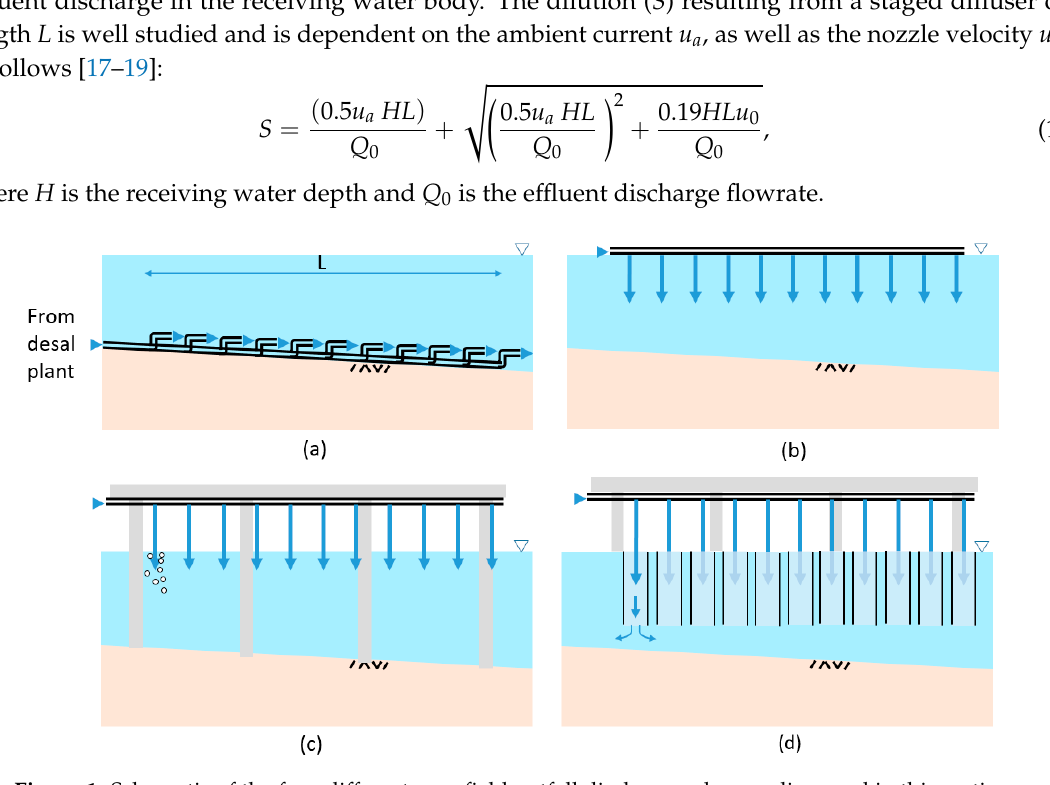
Figure 1. Schematic of the four different near field outfall discharge schemes discussed in this section: ( a ) bottom staged diffuser; ( b ) the surface plume; ( c ) unconfined plunging jets; ( d ) confined plunging jet reactors. In all of the schematic diagrams, the direction of the longshore ambient current is in and out of the paper.